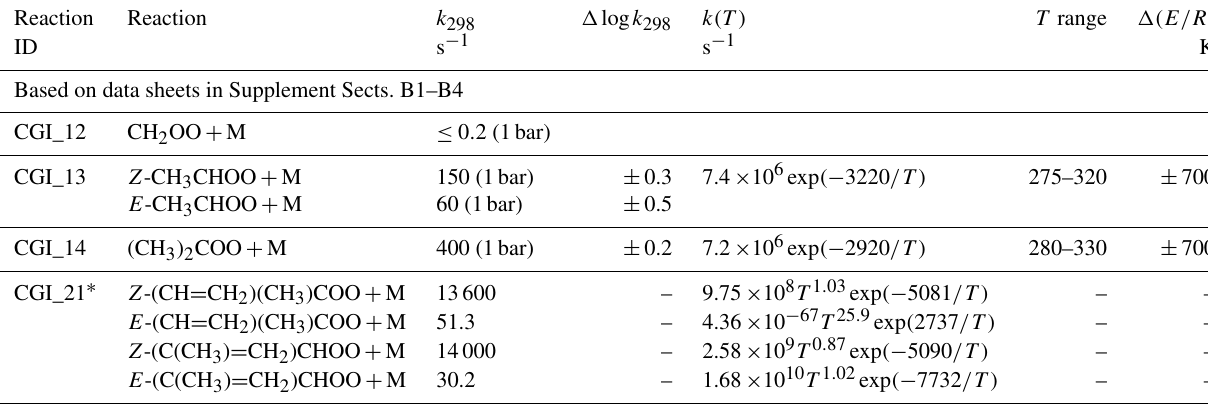
Table 6. Summary of recommended rate coefficients for gas-phase unimolecular reactions of sCIs.